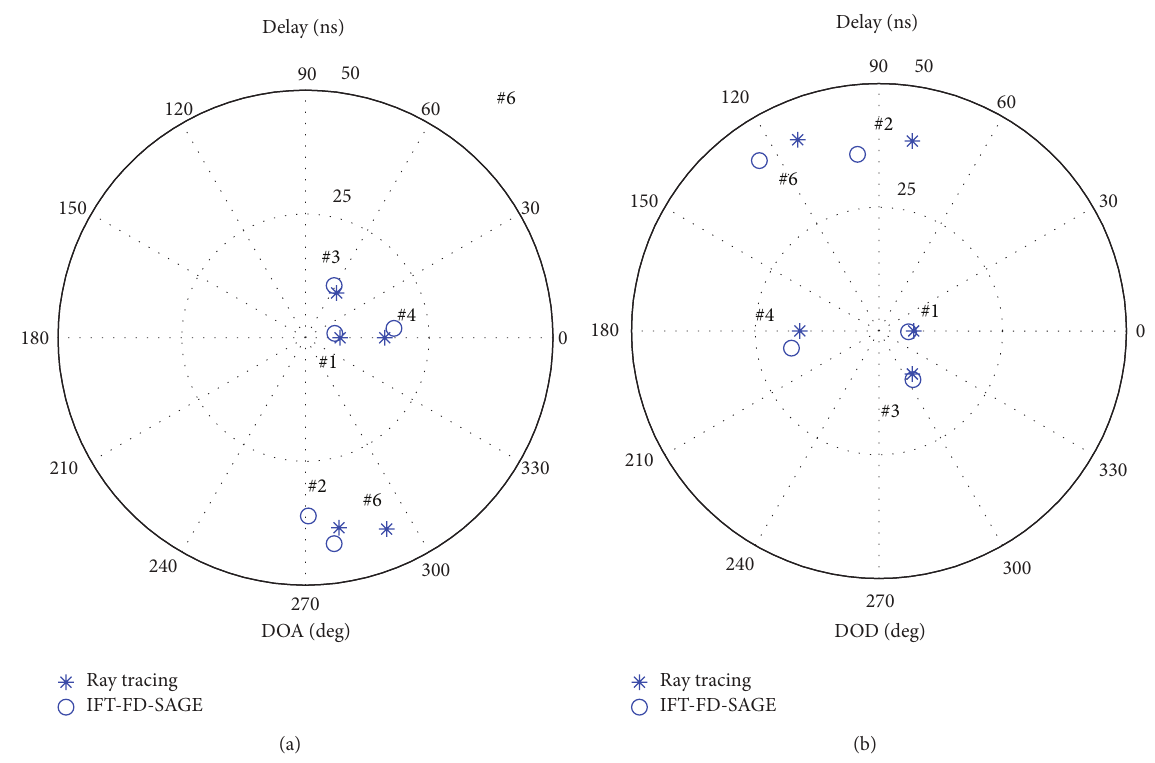
Figure 5: The results of IFT-FD-SAGE when applied to the measured data compared to their counterparts obtained from 2D ray tracing. number 1 is the direct path, number 2, number 3, and number 4 are the one-time reflected paths, and number 6 is the two-times reflected path; (a) is for the DOAs, and (b) is for the DODs.